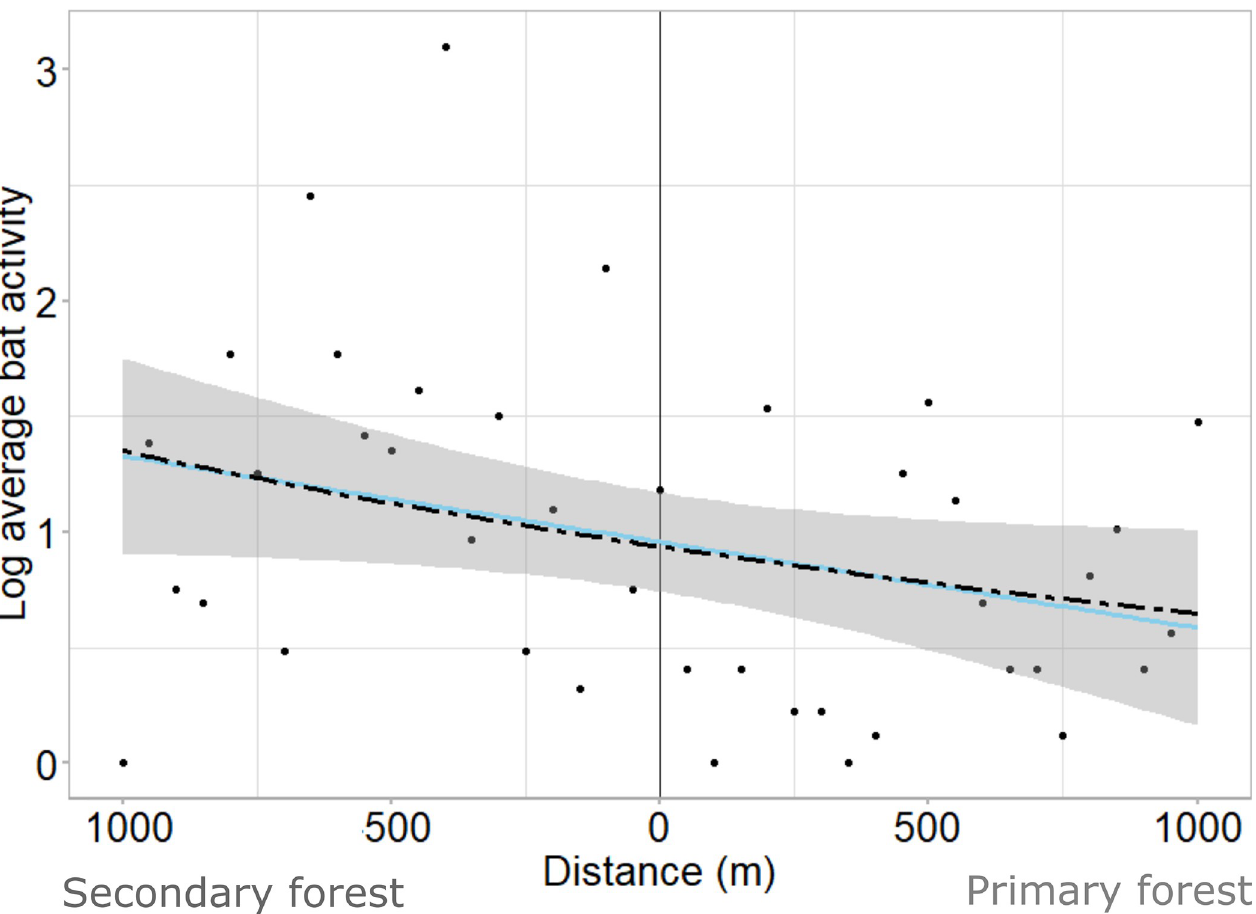
Fig 3. Edge effect model fit for forest specialists in the understory. Log forest specialist activity (bat passes) per 50 m sample point averaged across all transects with corresponding lines of best fit. Activity increases from the edge in the secondary forest and decreases from the edge in the primary forest. Dark blue dash–power model, light blue–linear model. Standard error provided for the linear model. Model parameters listed in S2 Table.